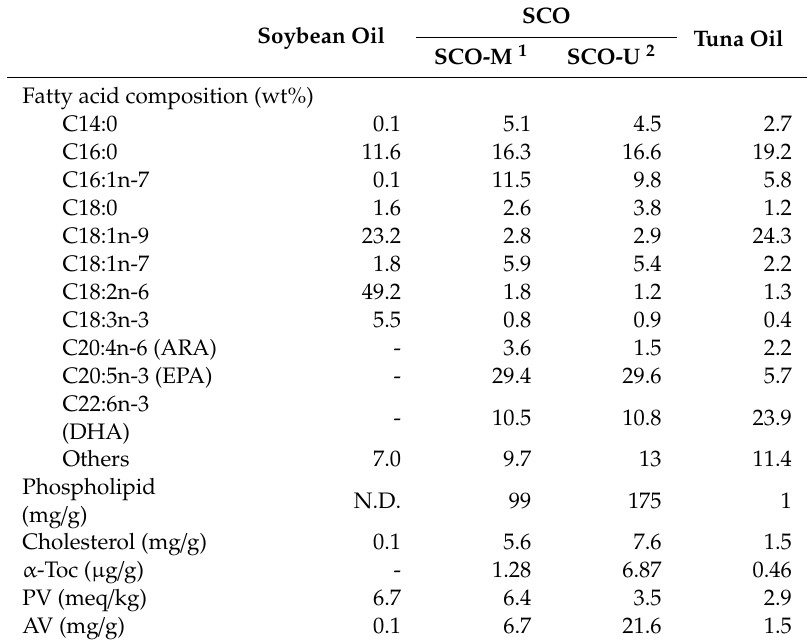
Table 1. Lipid composition of the experimental